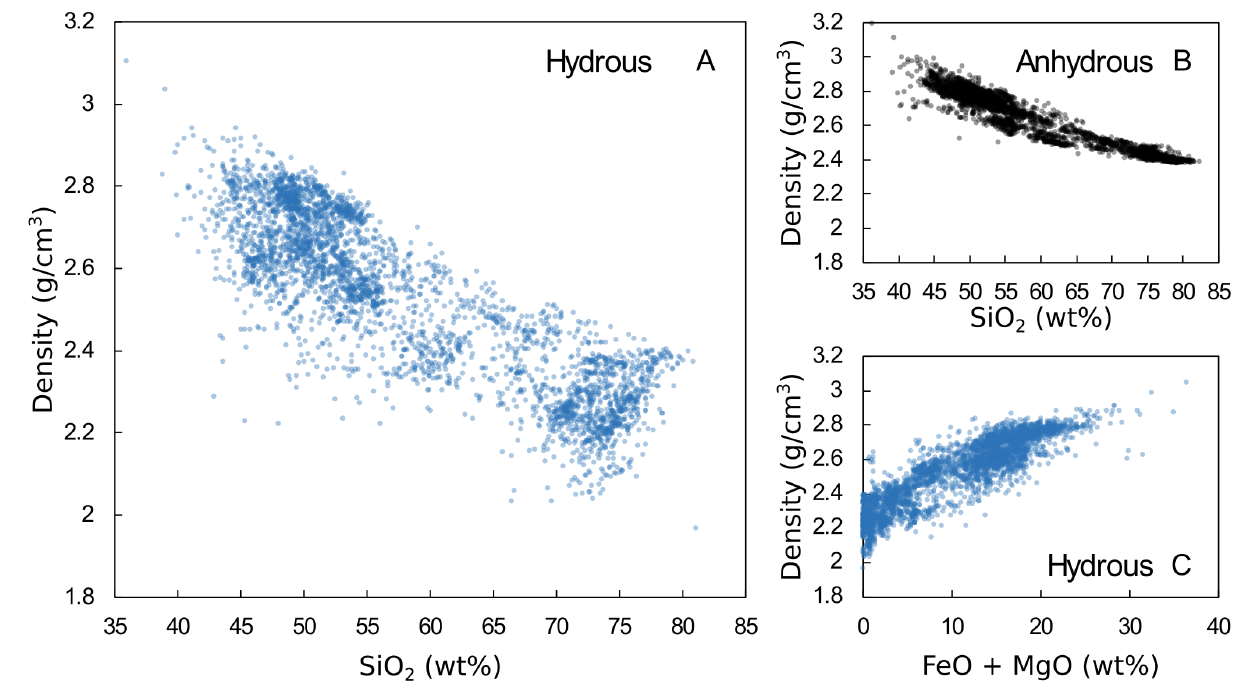
Figure 1: Calculated densities of over 3,000 melt inclusions (normalized to 100%) from volcanic settings around the world. All data from the GEOROC database (http://georoc.mpch-mainz.gwdg.de/georoc/). [A] The spread of densities of di ff erent magma types classified based on SiO tions. [B] The spread of densities calculated for anhydrous natural magmas. [C] MgO plus total Fe expressed as FeO shows a strong correlation with density, shown here for calculations including reported H